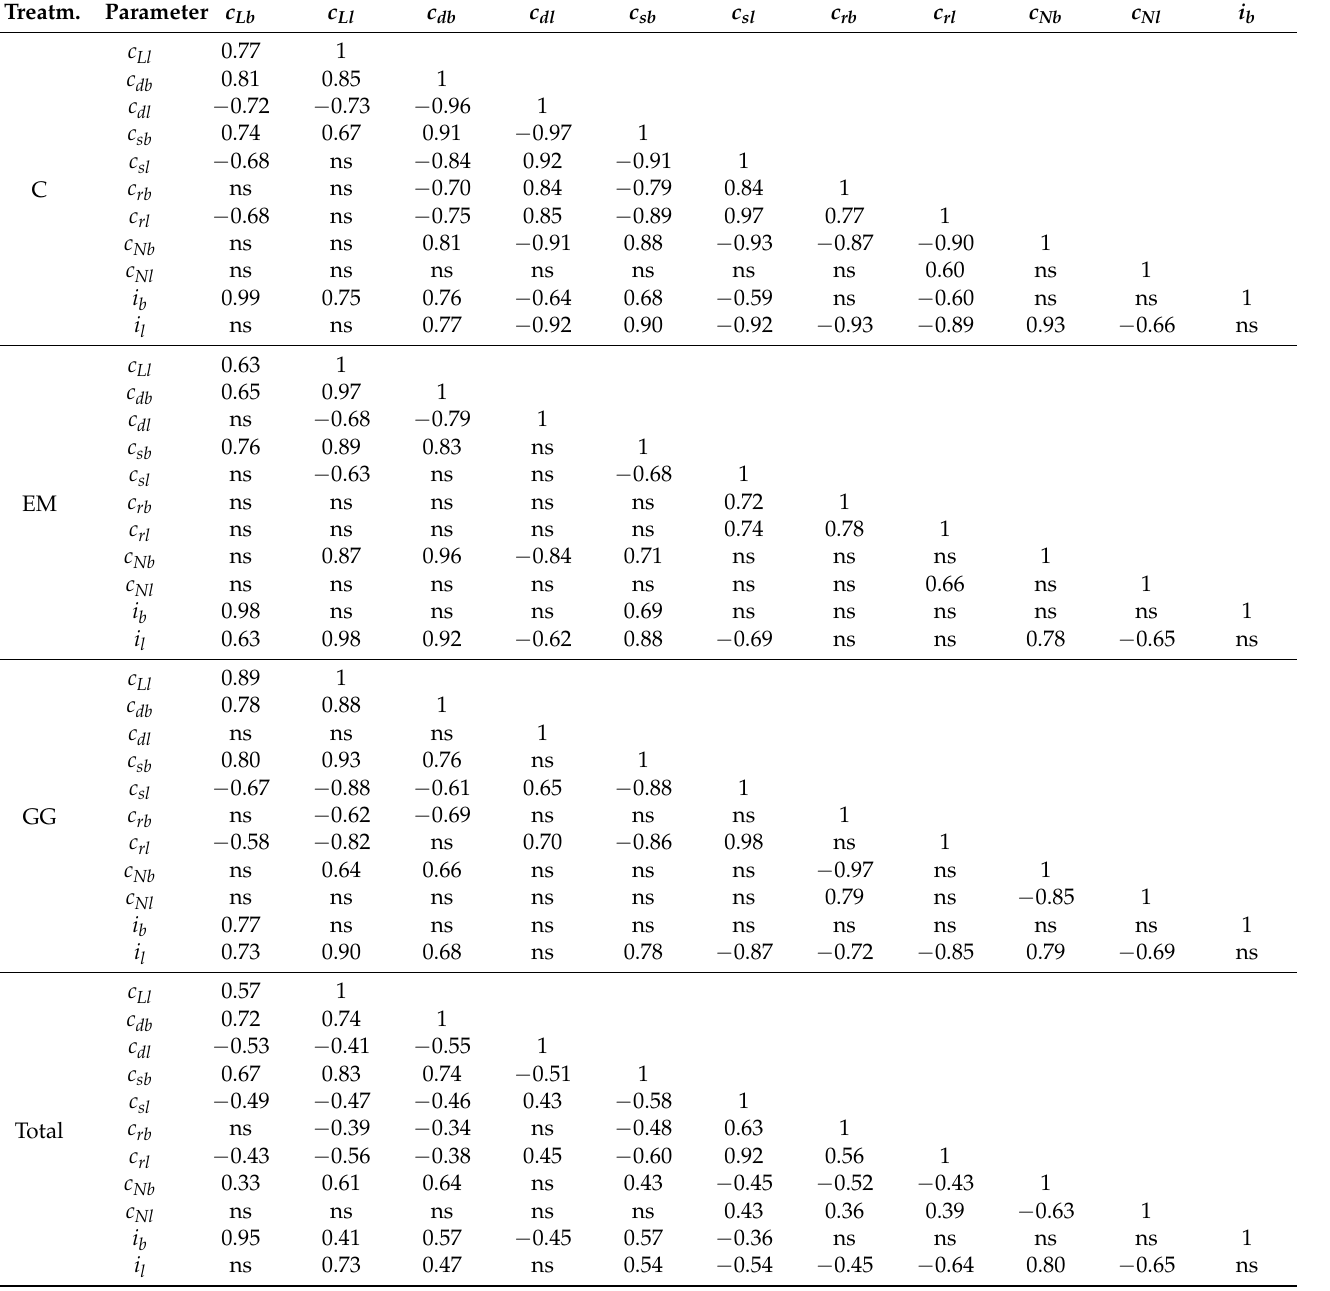
Table 11. Coefficients of Pearson’s correlation between the chemical composition parameters of shallot